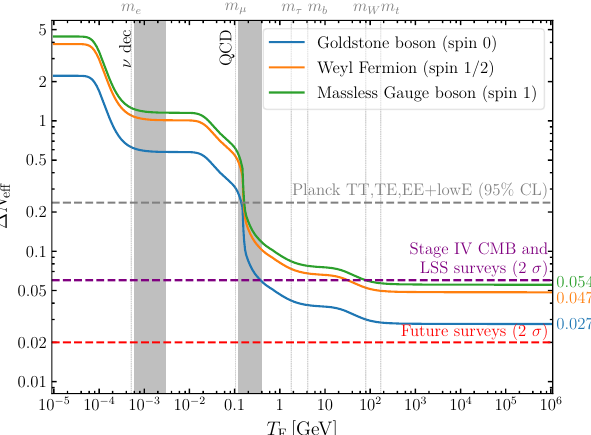
Figure 4. Contribution to ∆ N eff from new light particles with different spin: a Goldstone boson (blue line), a Weyl fermion (orange line), and a massless Gauge boson (green line). Vertical grey rectangles indicate the temperature of QCD phase transition ( ∼ 200 MeV) and the temperature of neutrino decoupling ( ∼ 1 MeV). Current Planck bounds already exclude the existence of particles decoupling after the QCD phase transition. Upcoming CMB and large-scale structure (LSS) surveys will improve by two orders of magnitude the limit on the decoupling temperature of new Gauge bosons and of new Weyl fermions. Finally, the sensitivity of future cosmological surveys, including 21 cm surveys, will allow us to exclude the presence of new light particles for any decoupling temperature and for any spin.